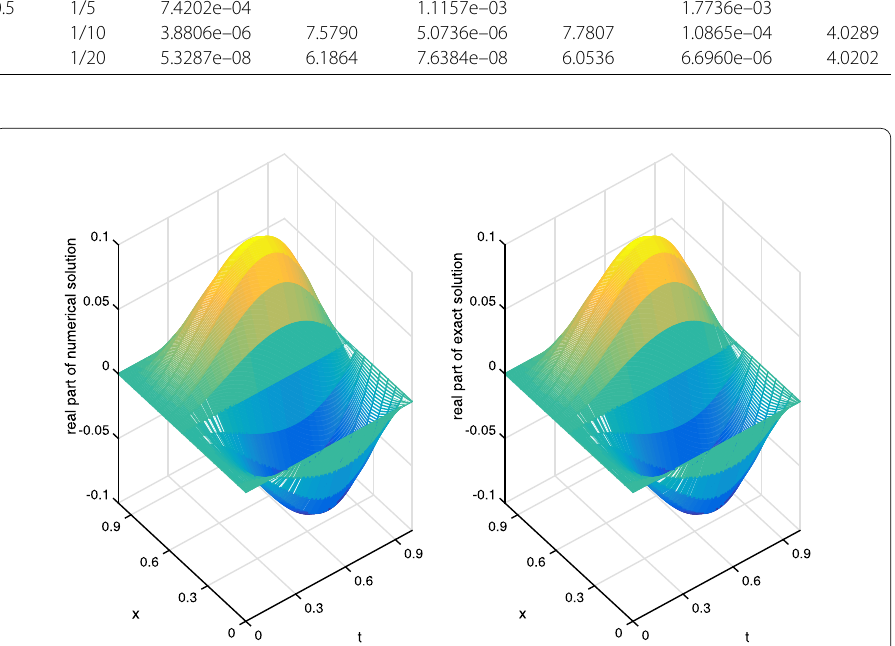
Figure 5 (Example 6.3) Real part of numerical solution and exact solution